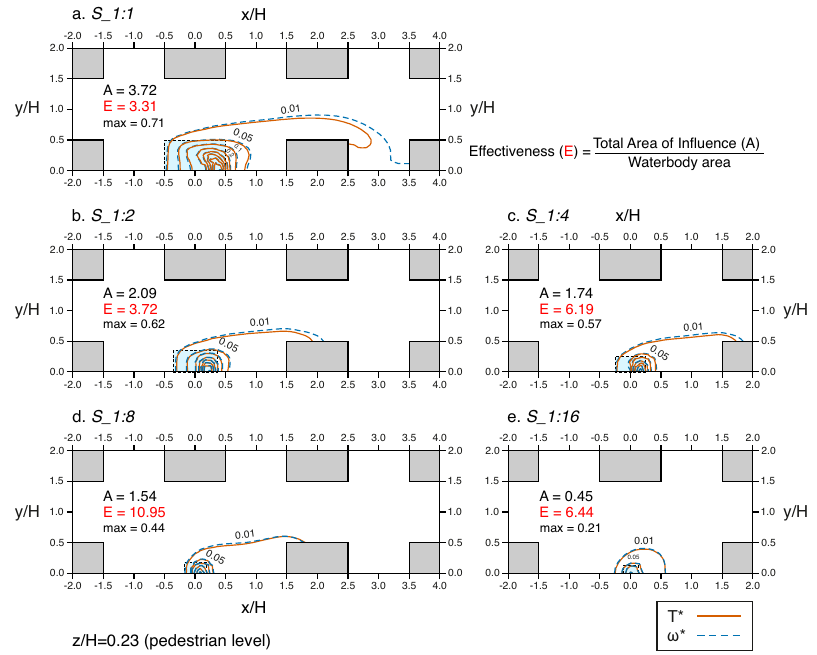
Figure 11. Contours of normalised temperature ( T ∗ ) and water vapour concentration ( ω ∗ ) over a horizontal plane at pedestrian level ( z / H = 0.23) for the warm water body cases ( ∆ T = + 2 K) and different water body sizes: ( a ) original size ( S_1:1 ); ( b ) half the original size ( s_1:2 ); ( c ) a quarter of the original size ( S_1:4 ); ( d ) one-eighth of the original size ( s_1:8 ); ( e ) one-sixteenth of the original size ( S_1:16